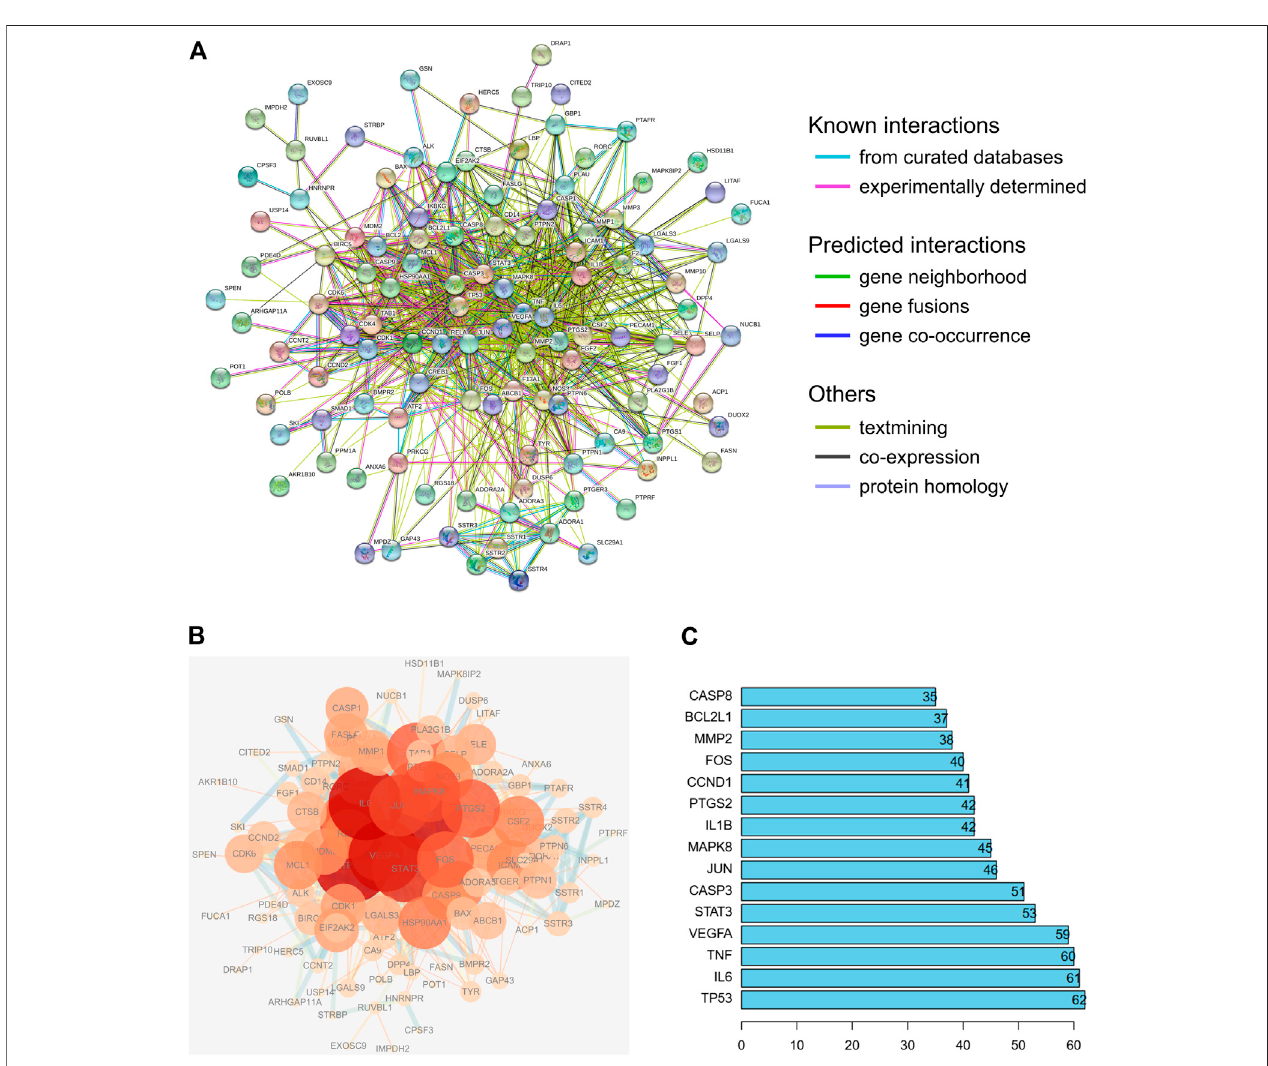
FIGURE4| PPInetworkanalysisoftheidenti fi edtargetsoftheactivecompoundsofCornusof fi cinalisandPaeonialacti fl ora. (A) Theinteractionsamongthetarget proteinsoftheselectedcompoundswasmappedbyconstructingaPPInetworktopresentthedirectandindirectregulatoryrelationshipbetweenthetargets.Thenature of theinteractionsisdifferentiated using lines ofdifferentcolors. (B) For visual analysisofthe target proteins, avisual PPInetwork diagram was generated toevaluate the topology parameters of the network nodes. The size and darkness of the nodes represent the number of degrees of each node. The thickness and color of the edges represents the combination score, with yellow and blue indicating lower and higher combination scores, respectively. (C) Analysis of core genes, ranked by the number of times that each gene appears among relationship pairs within the network diagram.